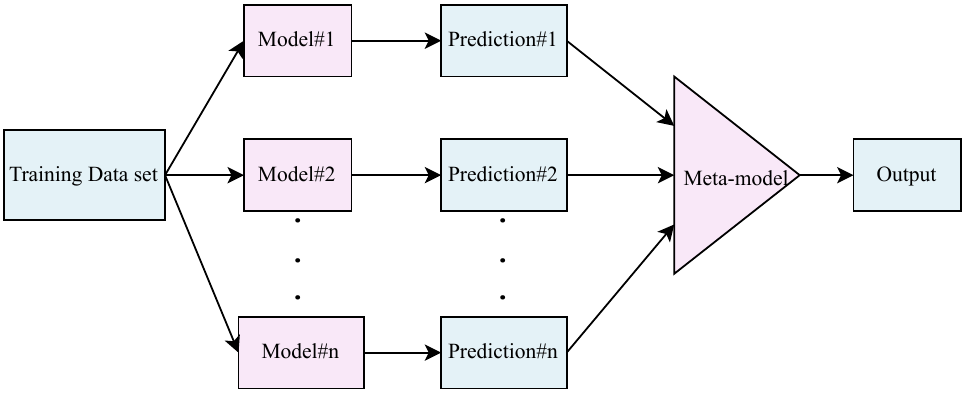
Figure 4. A block diagram of a stacking method using n models and one meta model